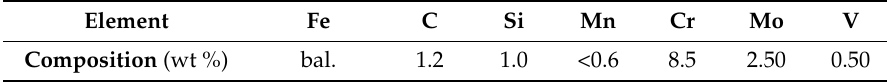
Table 1. Chemical compositions of the test steels (wt %).